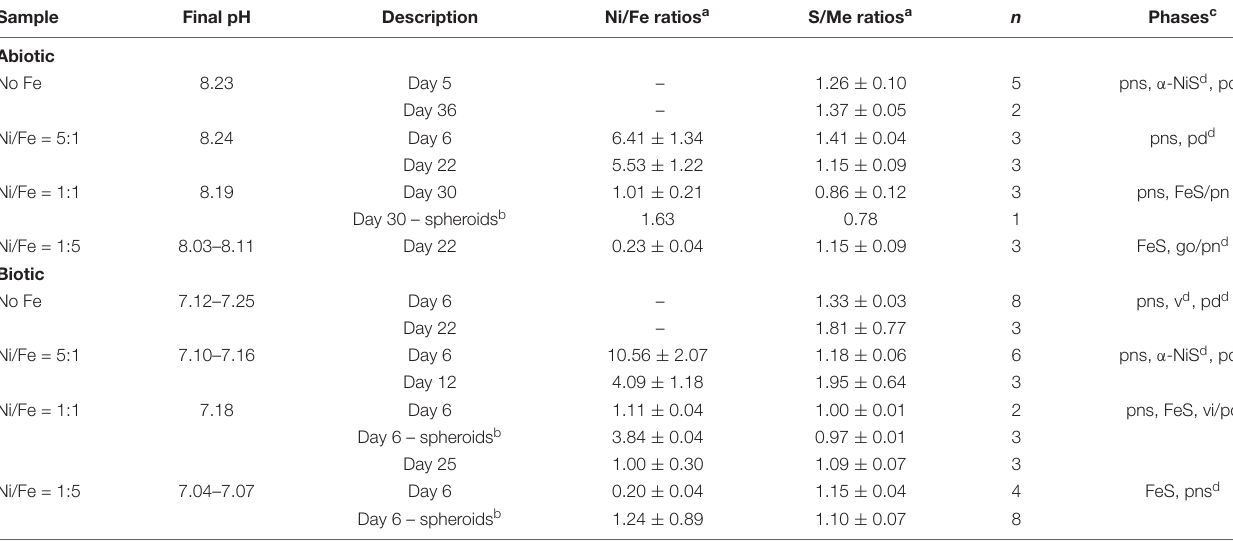
TABLE 2 | Solution pH, solid-phase molar elemental ratios and identity of mineral phases (determined by XRD and SADP) in the samples.